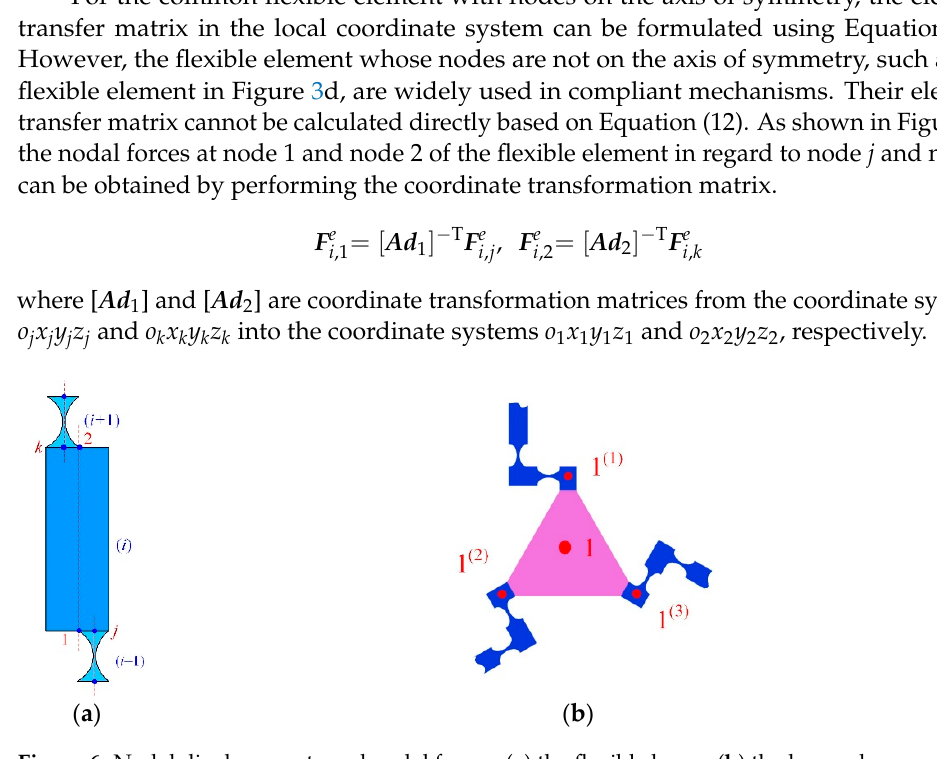
Figure 6. Nodal displacements and nodal forces: ( a ) the flexible beam; ( b ) the lumped mass.